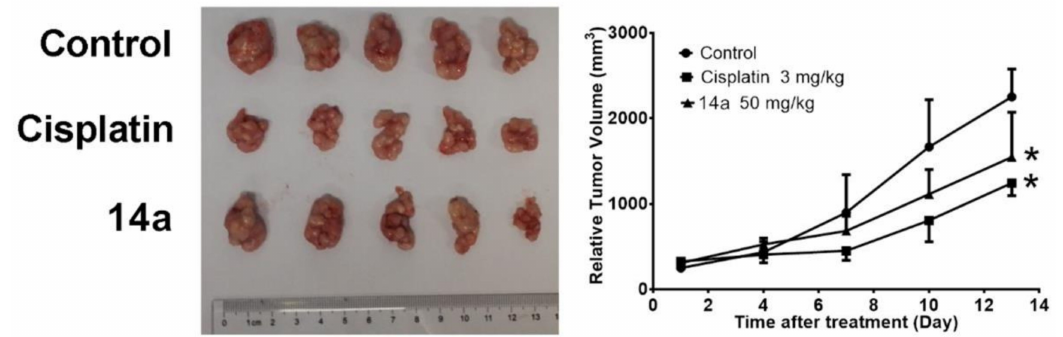
Figure 2. Effect of 14a on the growth of Hela in nude mice. Tumor diameter was serially measured with a vernier caliper to calculate the relative tumor volume. Each experiment was conducted using 5 mice per group. Vehicle ( • ); 50 mg/kg 14a ( (cid:78) ); and, 3 mg/kg cisplatin ( (cid:4) ). The statistical difference between the drug-treated group and the vehicle was determined by one-way ANOVA (* p <